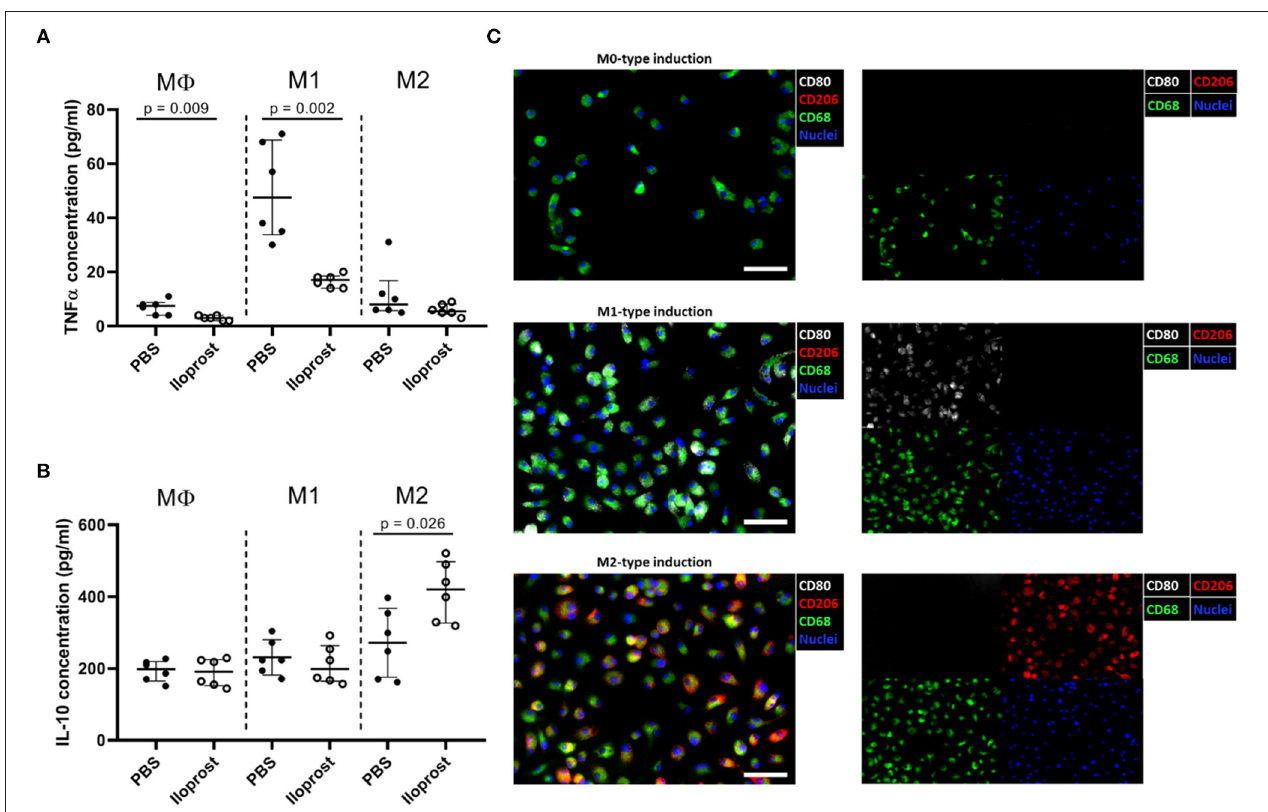
FIGURE 4 | Immunomodulatory effects of Iloprost on polarized bone marrow macrophages. Macrophages were polarized for 3 days toward the M1 or M2 type, supplemented with either PBS or 3 µ M Iloprost. (A,B) The following secreted cytokine concentrations were evaluated: TNF α (A) and IL-10 (B) of M1-type induced and M2-type induced polarized macrophages, respectively. (C) Representative immune fluorescence images of unpolarised CD68 + M 8 macrophages (on top), CD68 + CD80 + M1 macrophages (middle), and CD68 + CD206 + M2 macrophages (bottom). Color code of the immune fluorescence images: CD68 = green, CD80 = white, CD206 = red, and cell nuclei = blue (DAPI). Scale bars: 100 µ m; n =